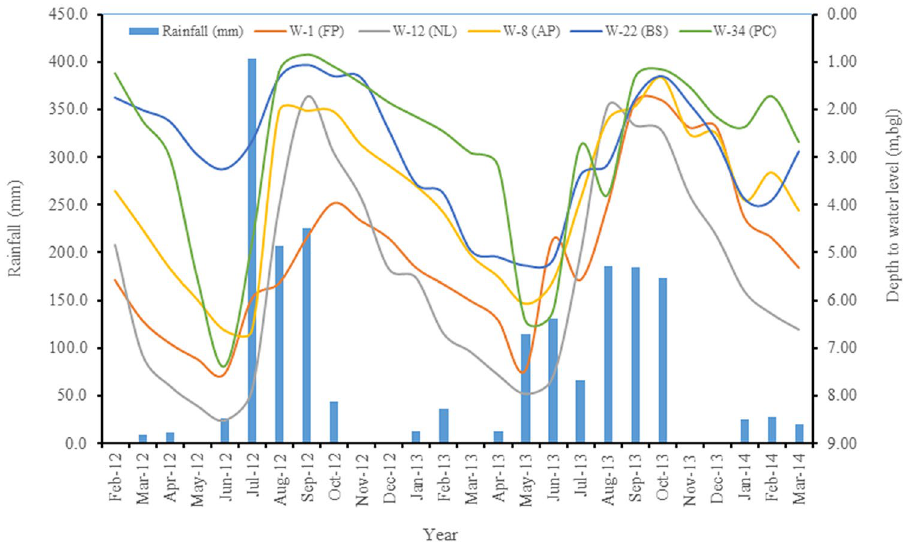
Figure 3. Well hydrographs corresponding rainfall in a morphodynamic system in a part of the Ganga basin of Northern India [FP: Flood Plain, NL: Natural Levees, AP: Active Flood Plain, BS: Back Swamp, and PC: